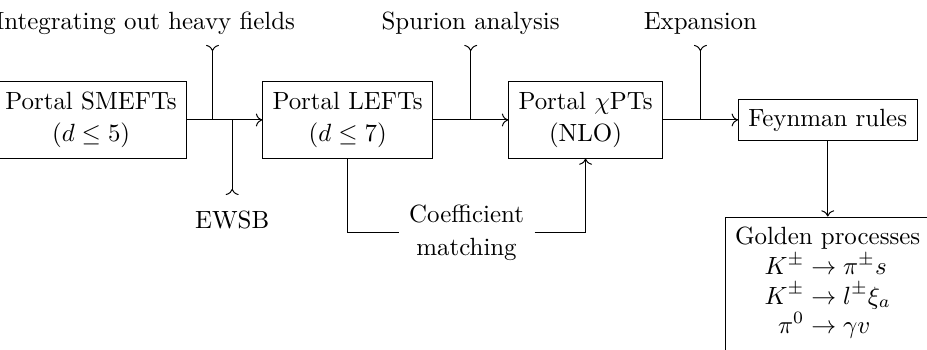
Figure 2. Overview of our procedure to derive the PET Lagrangian that couples the light mesons to messengers of spin 0, 1 , or 1. In the final step, we apply the Feynman rules extracted from the 2 portal Lagrangian to compute universal amplitudes for the three golden